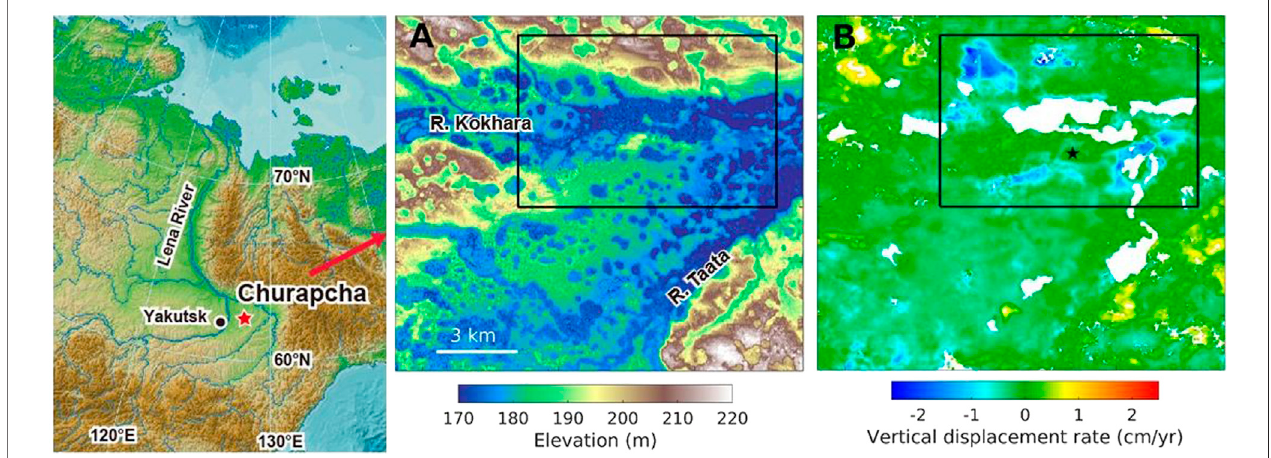
FIGURE 1 | Study area: (A) Elevation around Churapcha. (B) Vertical displacement rate derived from ALOS-2 InSAR stacking. The black rectangle indicates the area shown in Figure 2 . The black star in (B) indicates the location of the InSAR reference point.